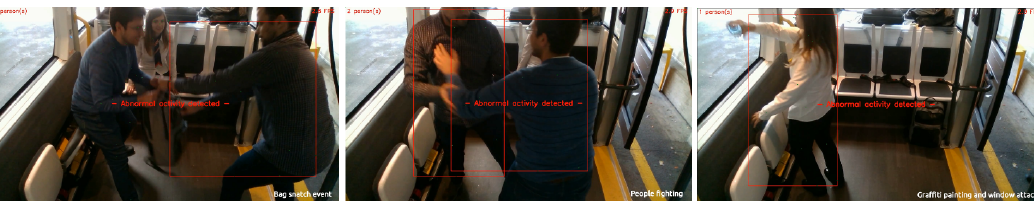
Figure 20. Evaluation across various scenarios ( left to right ): Bag-snatch, fighting, and vandalism.